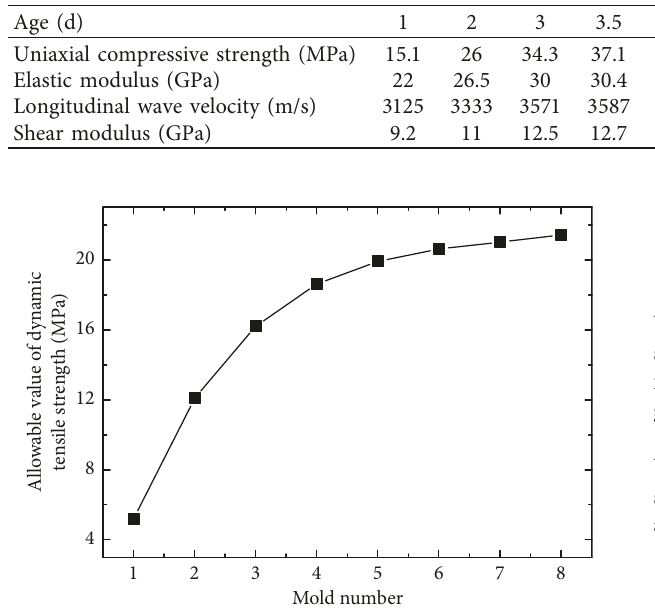
Figure 3: Dynamic tensile strength of C65 concrete in the different